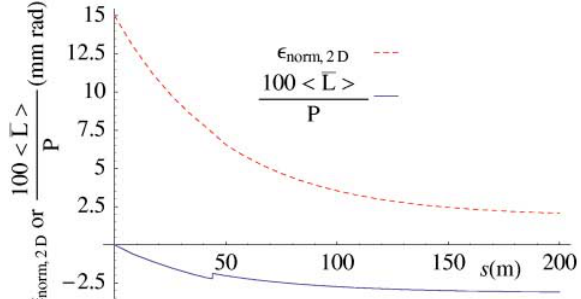
FIG. 5. (Color) Normalized two-dimensional emittance, and an- gular momentum, as a function of distance along the cooling channel. The small step at about 45 m corresponds to the change in absorber window thickness.